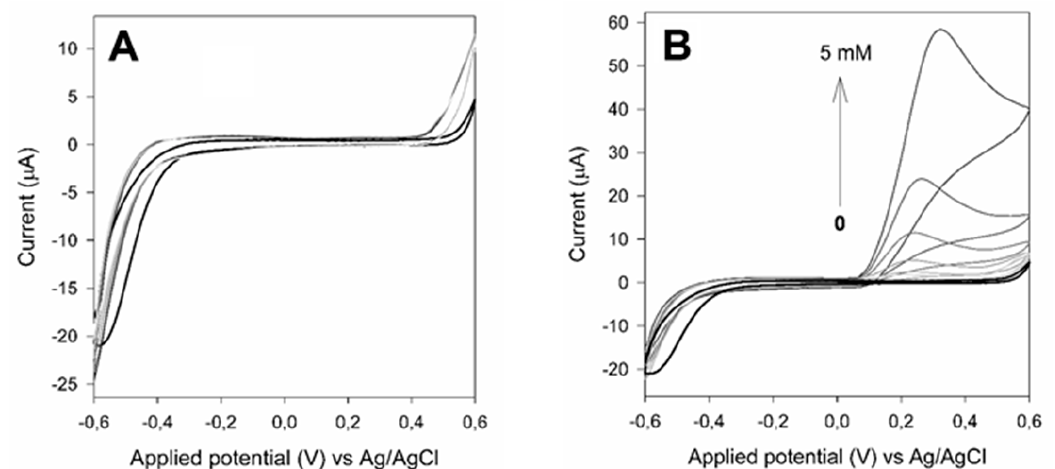
Figure 4. Cyclic voltammetry of graphite screen-printed electrodes (GSPEs) modified with SAMNs in the presence of xanthine ( A ) and uric acid ( B ). Measurements were carried out by dropping 2 µL of a suspension of 0.25 mg mL − 1 SAMN in 50 mM phosphate buffer, pH 7.5. Scan speed, 20 mV s − 1 . Black suspension of 0.25 mg mL − 1 SAMN in 50 mM phosphate bu ff er, pH 7.5. Scan speed, 20 mV s − 1 . Black line: no substrate. line: no substrate.